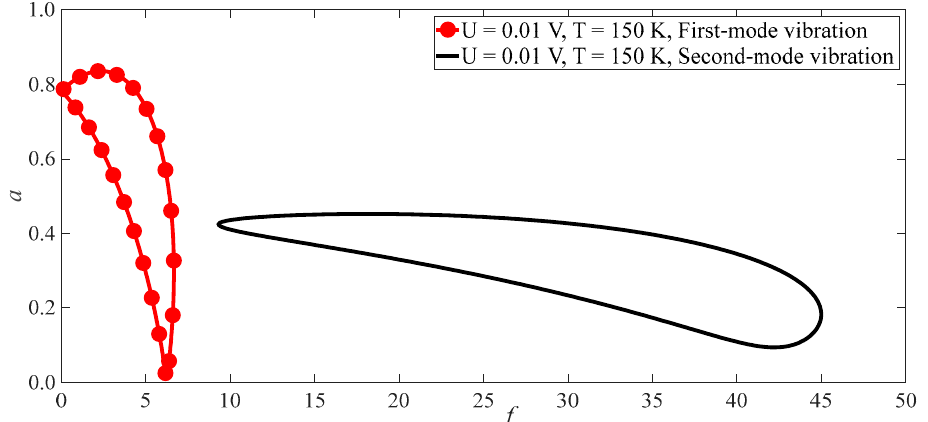
( ) ( ) σ = , 0.25,80 c and the sec- 1